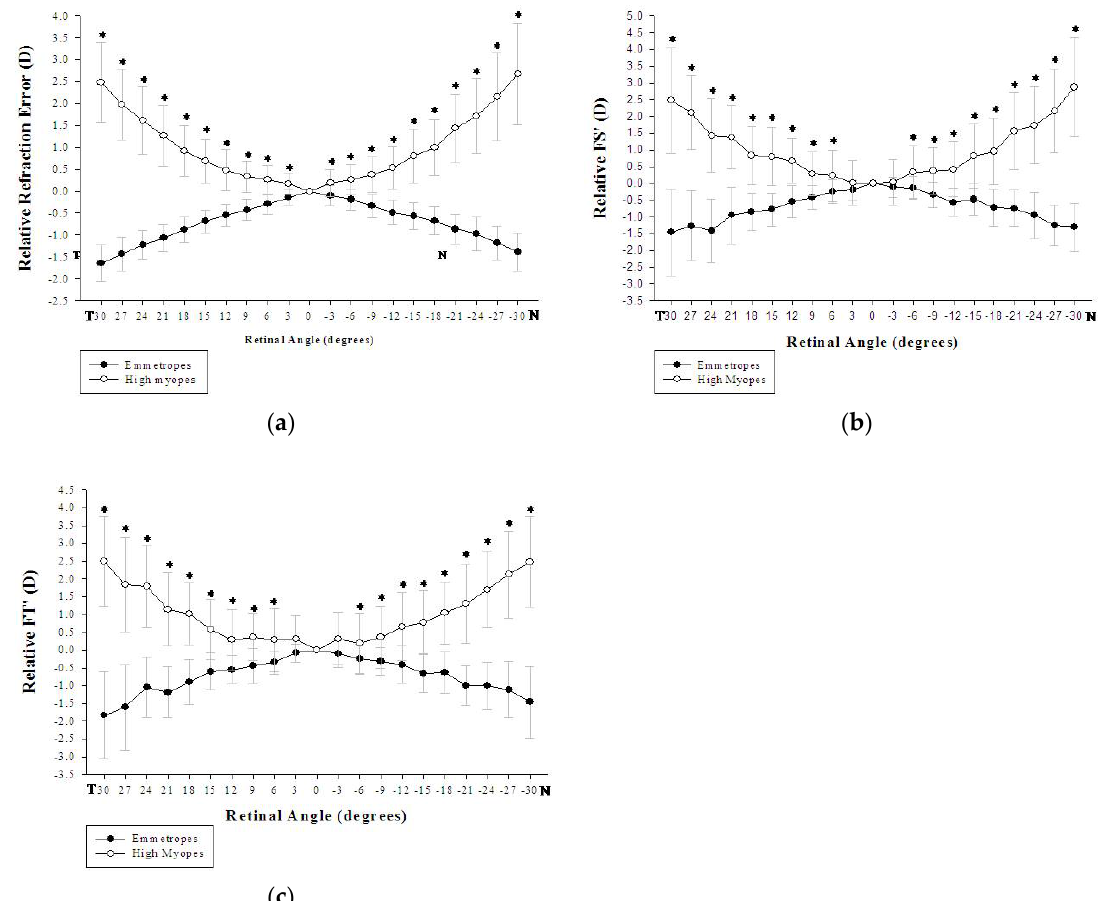
Figure 2. There were significant differences in the horizontally measured relative peripheral refraction between the emmetropic and high myopic groups in ( a ) Spherical equivalents at all of the eccentricities (* p < 0.001); ( b )Tangential refractive error (FT’) at all of the eccentricities (* p < 0.01); and ( c ) Sagittal refractive error (FS’) (* p < 0.01) except for T03 (* p = 0.067) and N03 (* p = 0.174).